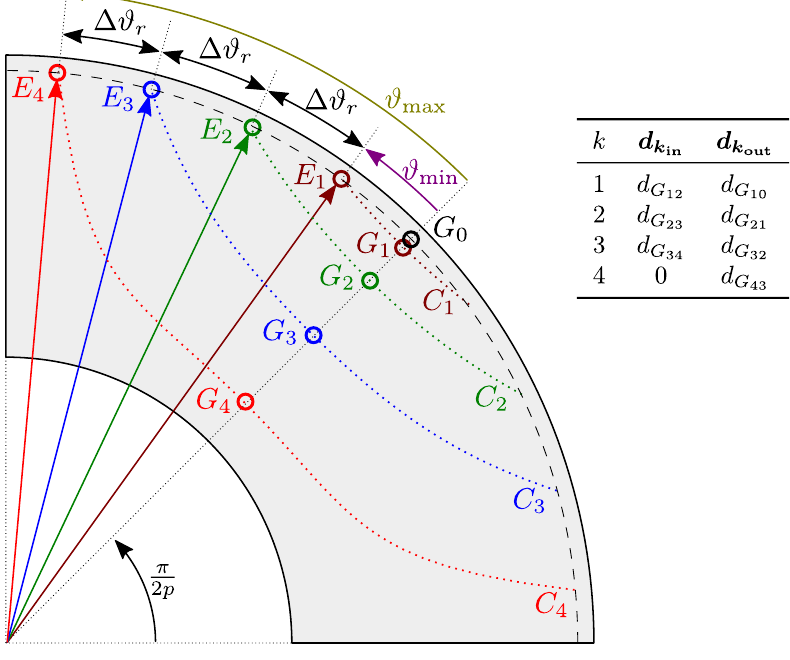
Figure 4. Construction of all flux